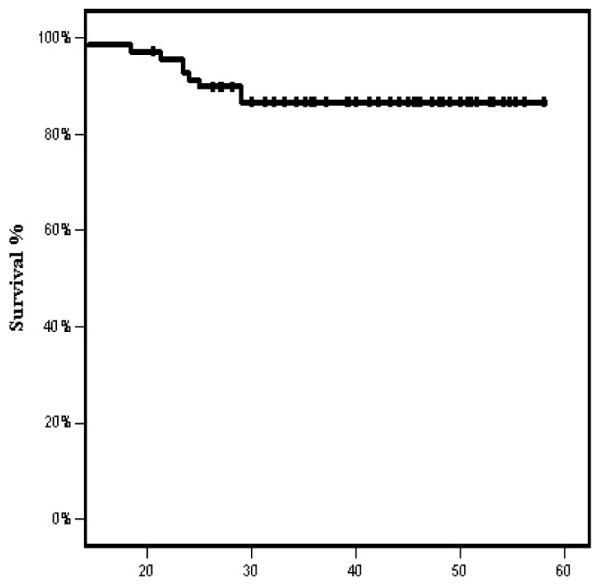
Overall survival in months.